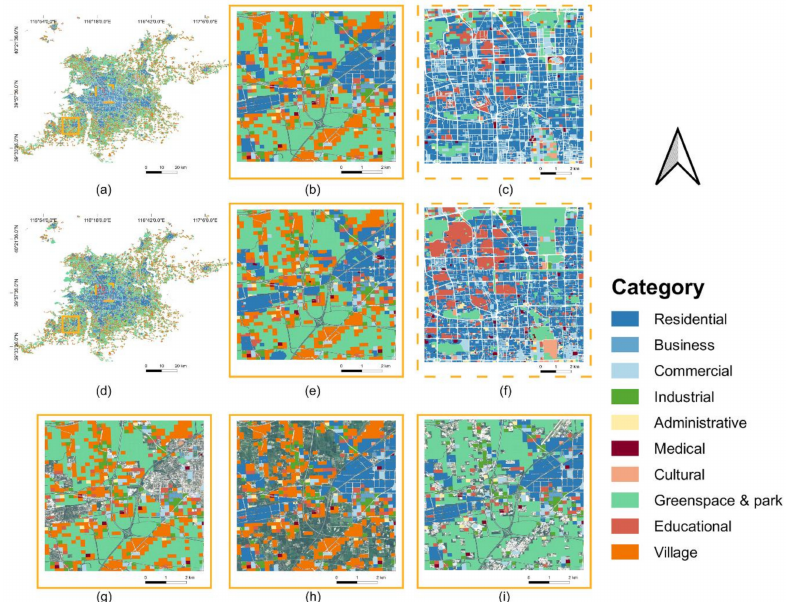
Figure 18. Comparison and zoomed-in views of EULUC-AOI (OSM+200 m grid) in Beijing, 2019. ( a ) The mapping results before overlaying the AOIs layers; ( b , c ) zoomed-in views of ( a ); ( d ) the mapping results after overlaying the AOIs layers; ( e , f ) zoomed-in views of ( d ). The zoomed-in views with solid lines outside show details in the solid box in the lower-left corner of the mapping results. The zoomed-in view with dashed lines outside shows details in the dashed box near the middle of the mapping results. ( g – i ) The results of ( b ) with the removal of residential, greenspace, and village units in turn, with Sentinel II optical images in the